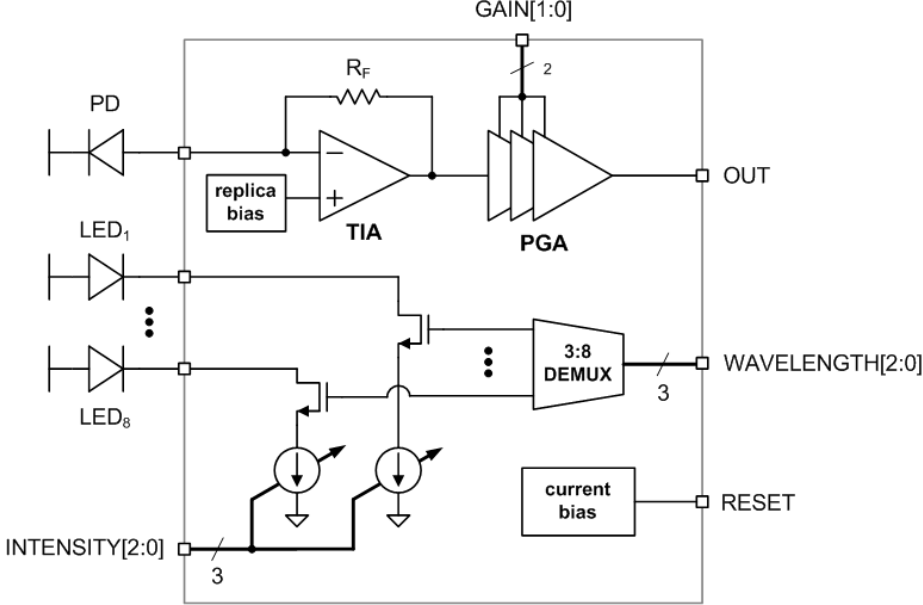
Figure 8. Architecture of the implemented NIR spectroscopy module.